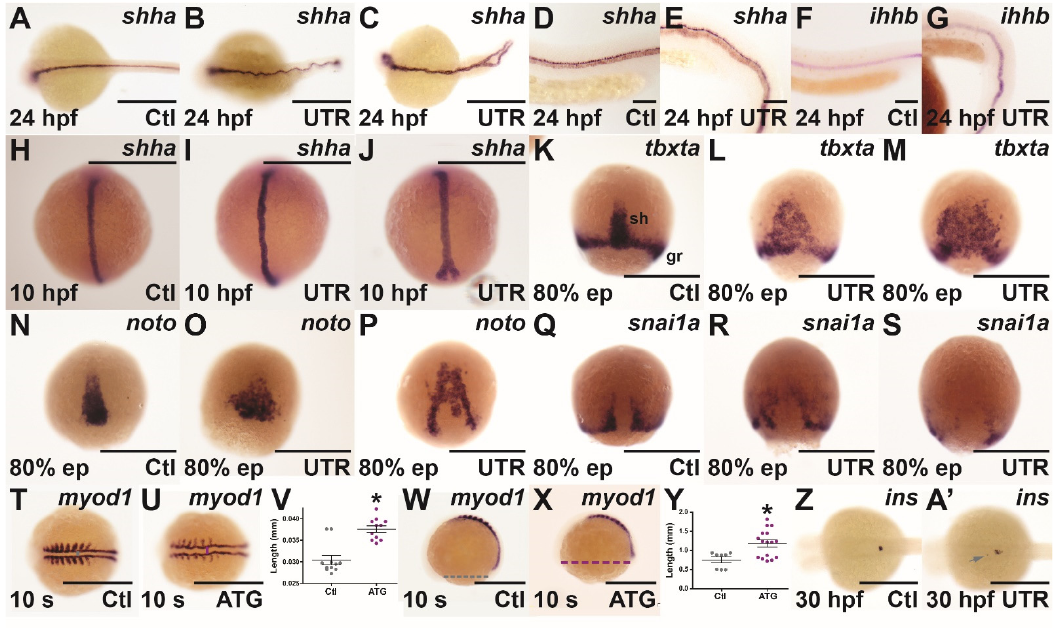
Figure 2. Phenotypic consequences of socs4a knockdown. Schematic of socs4a mRNA showing exons boxed and joined by a thin line, with non-coding sequence in blue and coding in grey. Sequences targeted by ATG MO (purple) and UTR MO (pink) are indicated ( A ). Confirmation of ATG MO efficacy by in vitro transcription and translation of socs4a in the presence of control (Ctl) or ATG MO with the arrow indicating the position of the Socs4a protein at ~44 kDa and the asterisk a non-specific protein ( B ). Analysis of embryos injected with Ctl ( C , F , K , N , P ), ATG ( D , E , L , O , Q ) or UTR ( G ) MO, or combined UTR MO with MO-resistant socs4a mRNA (UTR/RNA, ( H )) or with p53 MO (UTR/p53, ( I )) by either light microscopy ( C – I , K – L , N – O ) or fluorescence microscopy of phalloidin (Ph) staining of muscle fibers ( P , Q ). All embryos are positioned with their anterior to the left and images are lateral view. Scale bars = 0.5 mm ( C – I ) or 0.1 mm ( K – L , N – Q ). The ventral curl phenotype in Ctl, ATG, UTR, UTR/RNA and UTR/p53 MO was quantified, and shown as mean ± SEM, with statistical significance versus Ctl ( p < 0.05: *; p < 0.01: **) or UTR ( p < 0.05: #) shown ( J ). Embryo length (anterior–posterior) at 4 dpf is provided for individual embryos, with mean ± SEM and statistical significance versus Ctl indicated ( p < 0.05: *) ( M ). Abbreviations: fp, floor plate; hc, hypochord; sb, somite boundary.